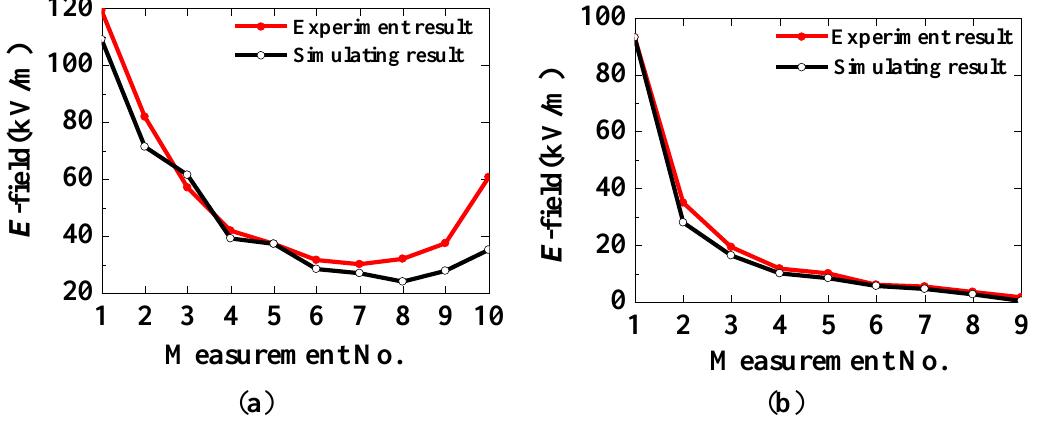
Figure 23. E-field distribution along the insulators with r = 30 mm ( a ) in the axial direction and ( b ) in the radial